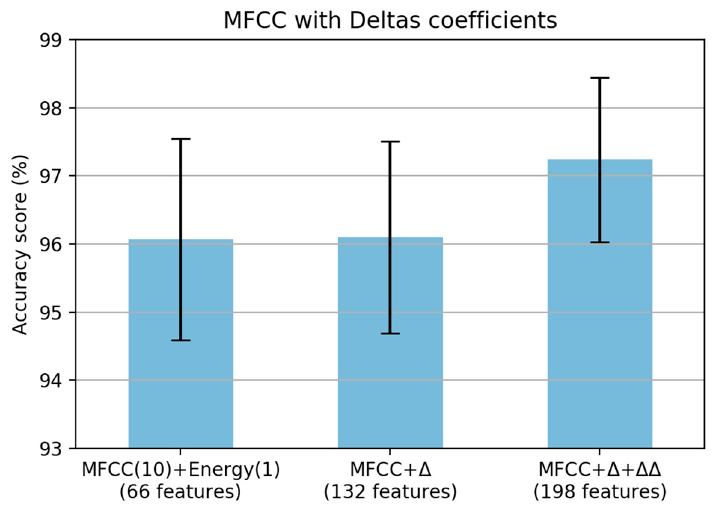
Figure 11. Accuracy score based on MFCC with deltas coefficient. Sensors 2019 , 19 , x FOR PEER REVIEW